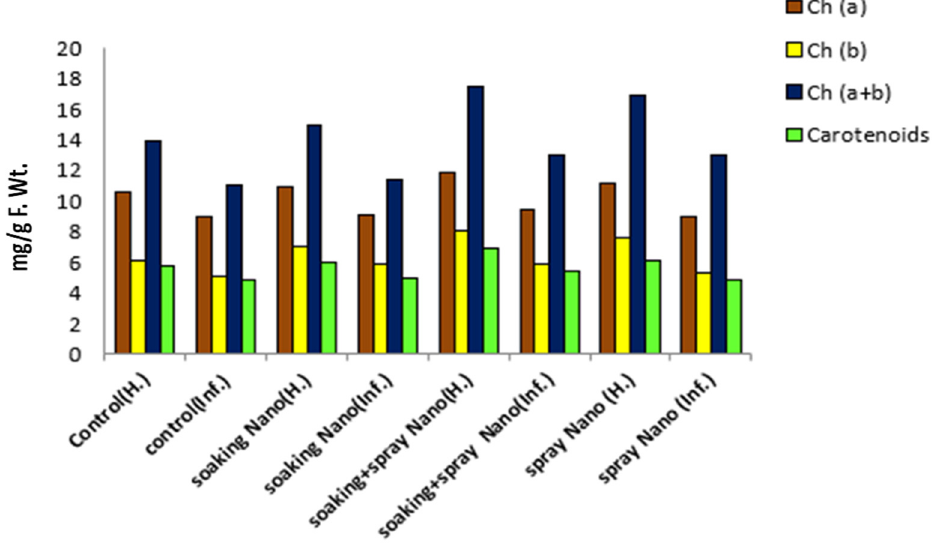
Figure 5. Effect of Se-NPs on the photosynthetic pigment’s indicators of ( Vicia faba